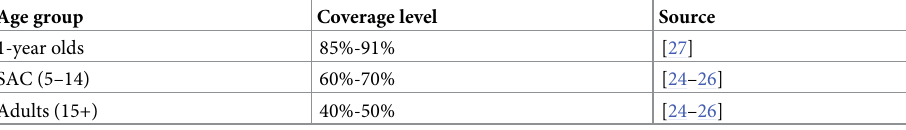
Table 3. Vaccination coverage achieved for HPV and